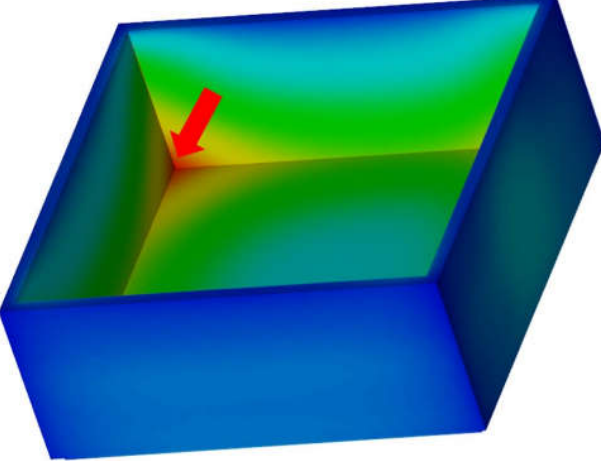
Figure 3. Hot spot in the corner of the part.